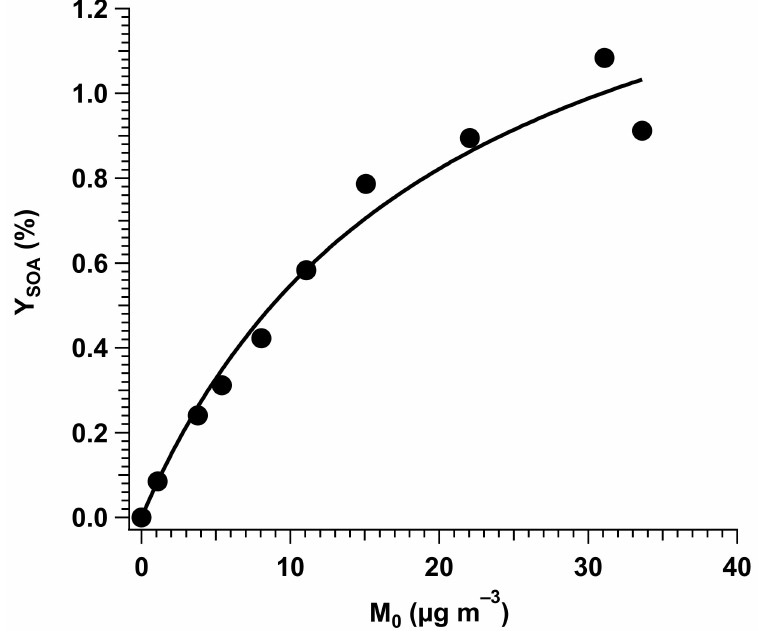
Figure 9. SOA formation yields Y SOA vs. aerosol mass concentrations M 0 for T2P ozonolysis in the ASC chamber ([T2P] 0 = 2.1–4.5 ppm and [O 3 ] 0 = 65–516 ppb). The line corresponds to a fit using Equation